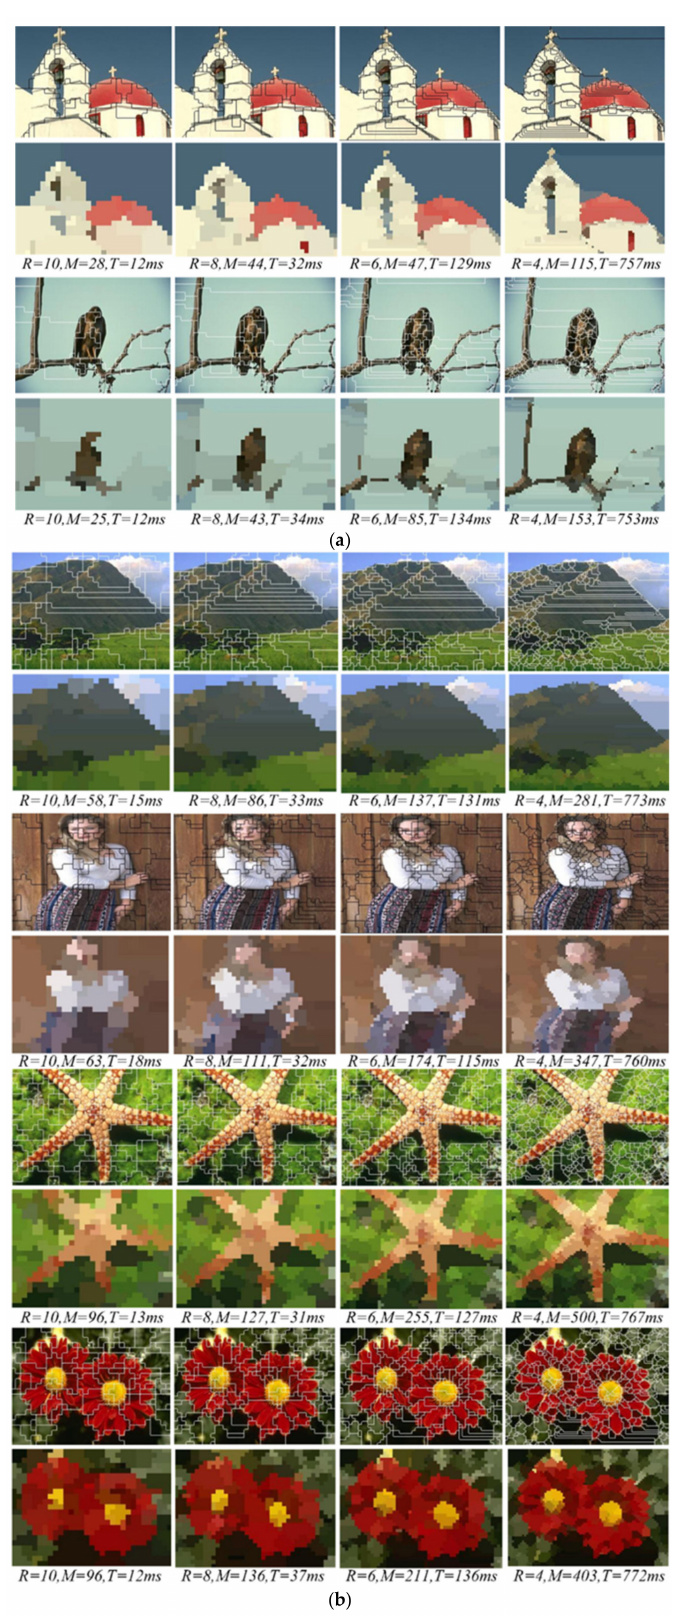
Figure 9. The superpixel segmentation results. The segmentation results are obtained with the different R . ( a ) The images which include the large smoothly connected homogenous regions are segmented by fewer and larger superpixels. ( b ) The images which include the complex textures and contours are segmented by more and smaller